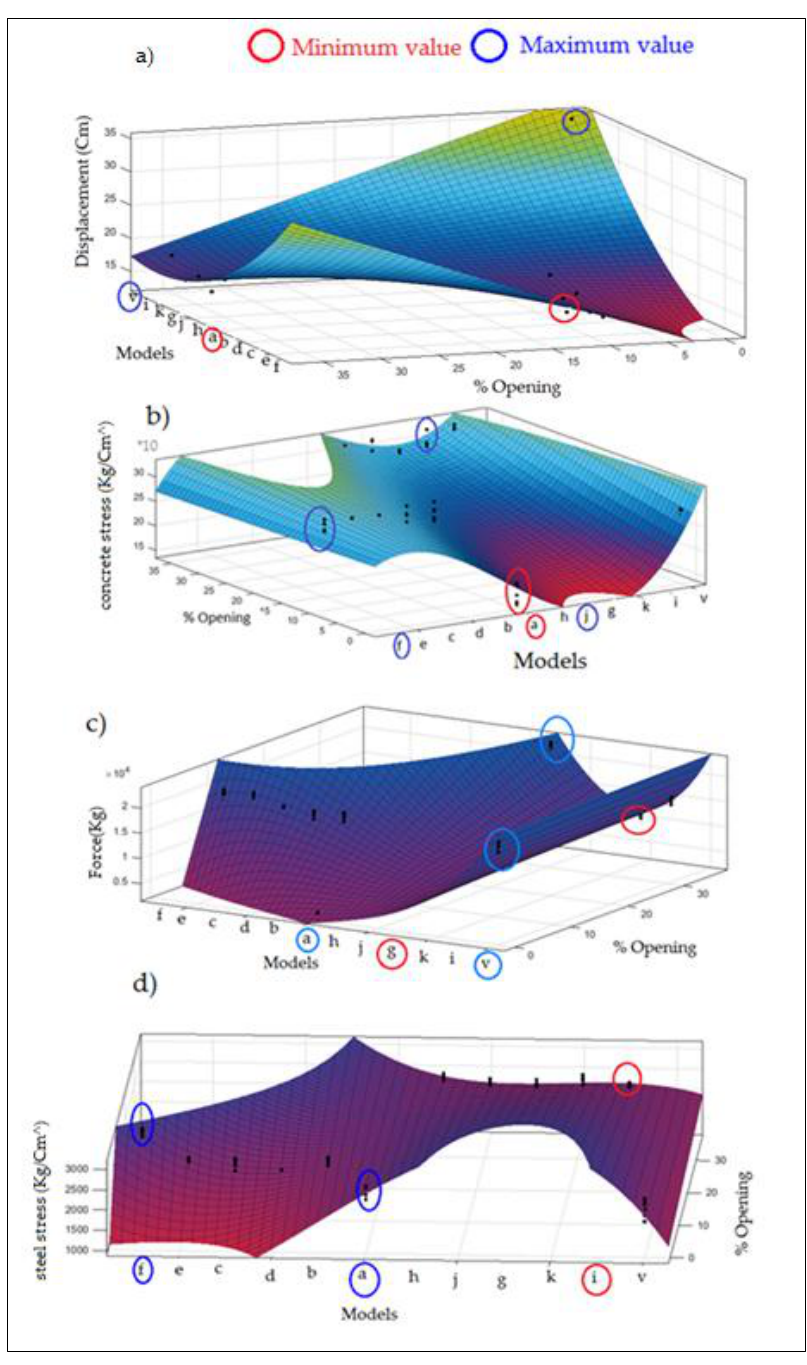
Figure 37. Fit toolbox result for neural network results ( a ) displacement; ( b ) concrete stress; ( c ) Force; ( d ) steel stress.